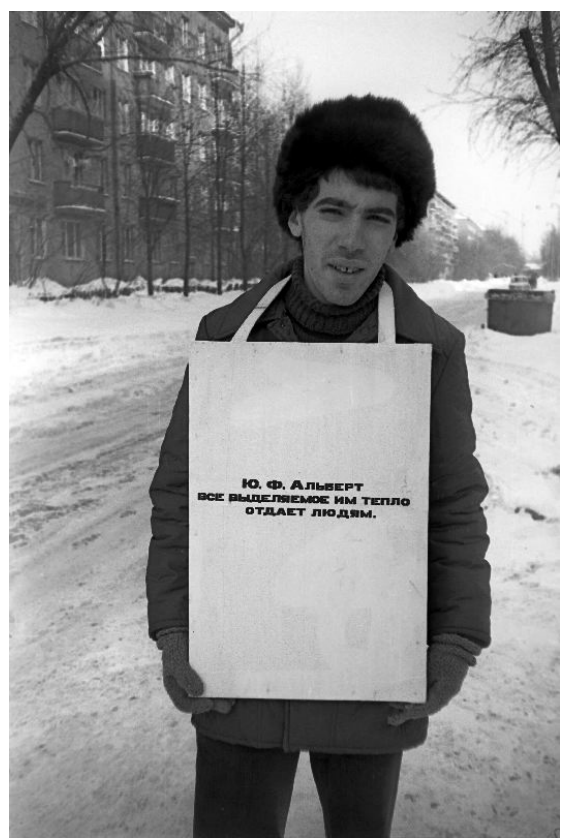
Figure 14. Albert. Y. F. Albert gives his entire share of warmth to others . 1978. Black-and-white Figure 14. Albert . Y. F. Albert gives his entire share of warmth to others. 1978. Black-and-white photo- graph. 30 cm × 20 cm. Courtesy of the artist. photograph. 30 cm × 20 cm. Courtesy of the